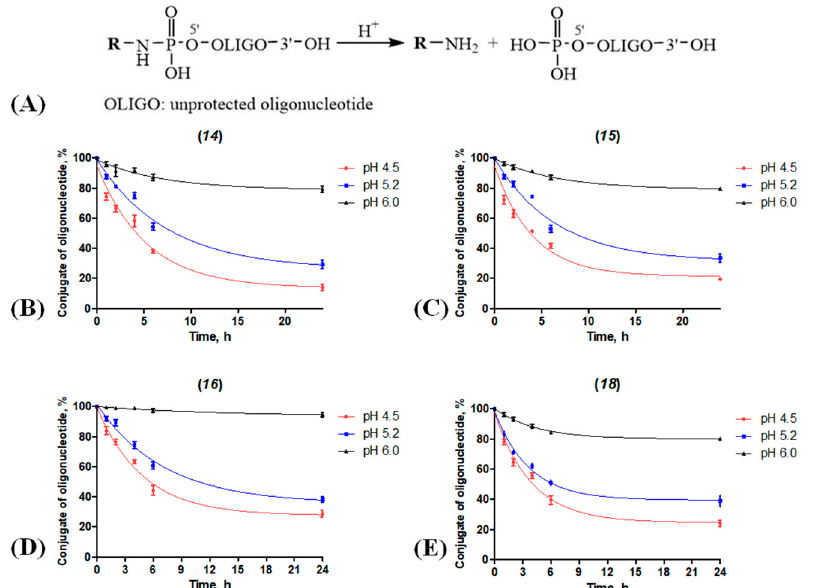
Figure 5. Scheme of hydrolysis ( A ) and kinetic curves of P-N-bond cleavage in conjugates of 5 ′ -p- siDmS ( 14–16, 18 , Table 1) with p -anisic acid ( B ), cholesterol ( C ), oleyl ( D ) and GalNAc ( E ) at different pH values. Quantification of the full-size conjugate (%, axis Y) in relation to incubation time and pH. The results are presented as mean values (±SD) from three independent experiments. Section 3: Materials and Methods for details.